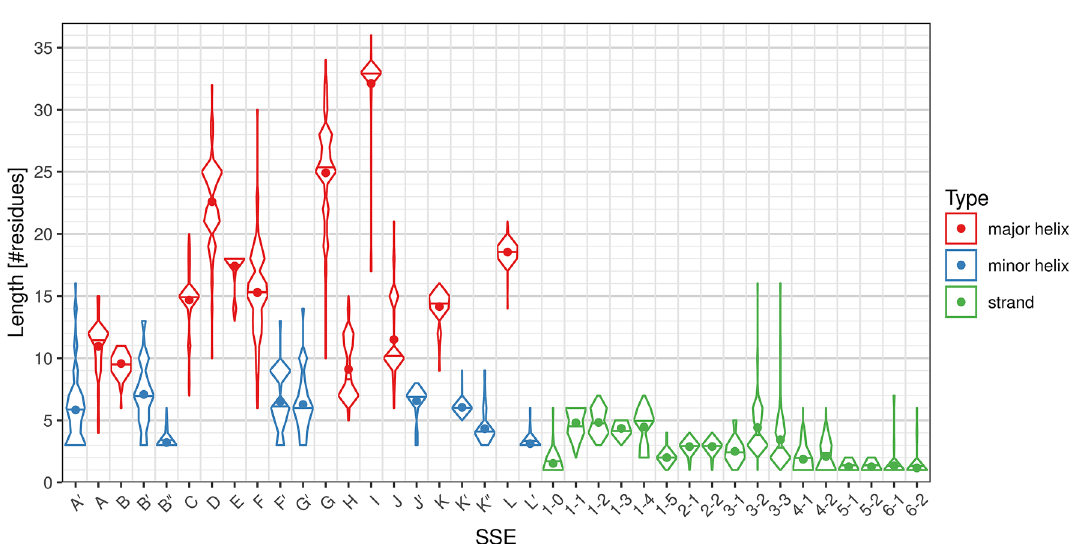
Figure 3. Distributions of length of individual SSE classes. The dots in the violin plot represent the mean, horizontal lines represent the median of the distribution. Non-existing SSEs are not included in the Strands. In sheet β1, strands β1-1, β1-2, β1-3, β1-4 are always present, β1-5 is found in 96% of the structures, β1-0 in 44%. Strand β1-0 is less frequent because it is very short, and it is in the region of variable secondary structure before helix A. Sheet β2 is always present. In sheet β3, strands β3-2, β3-3 are present in more than 98%